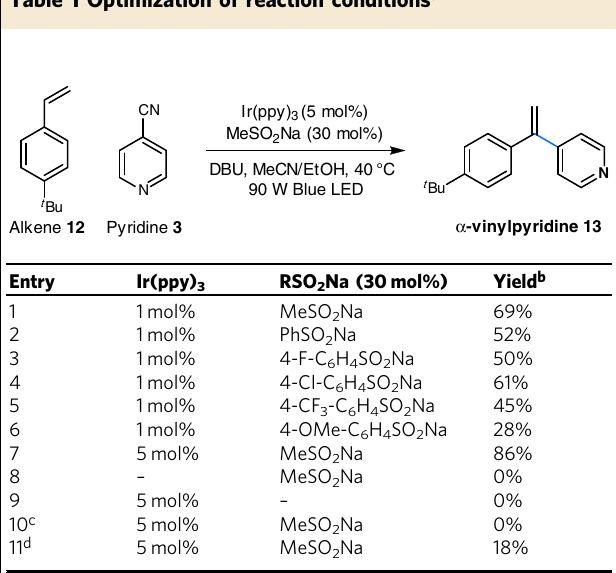
Table 1 Optimization of reaction conditions